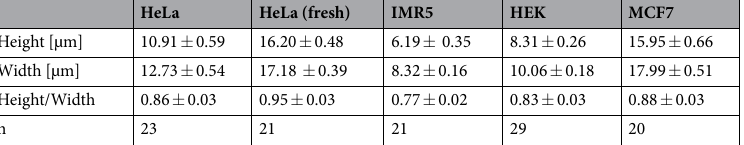
Table 1. Dimensions of all measured nuclei. All values are mean ± s.e.m. The height was obtained with AFM. The width was obtained optical microscopy by taking the mean of the short and long